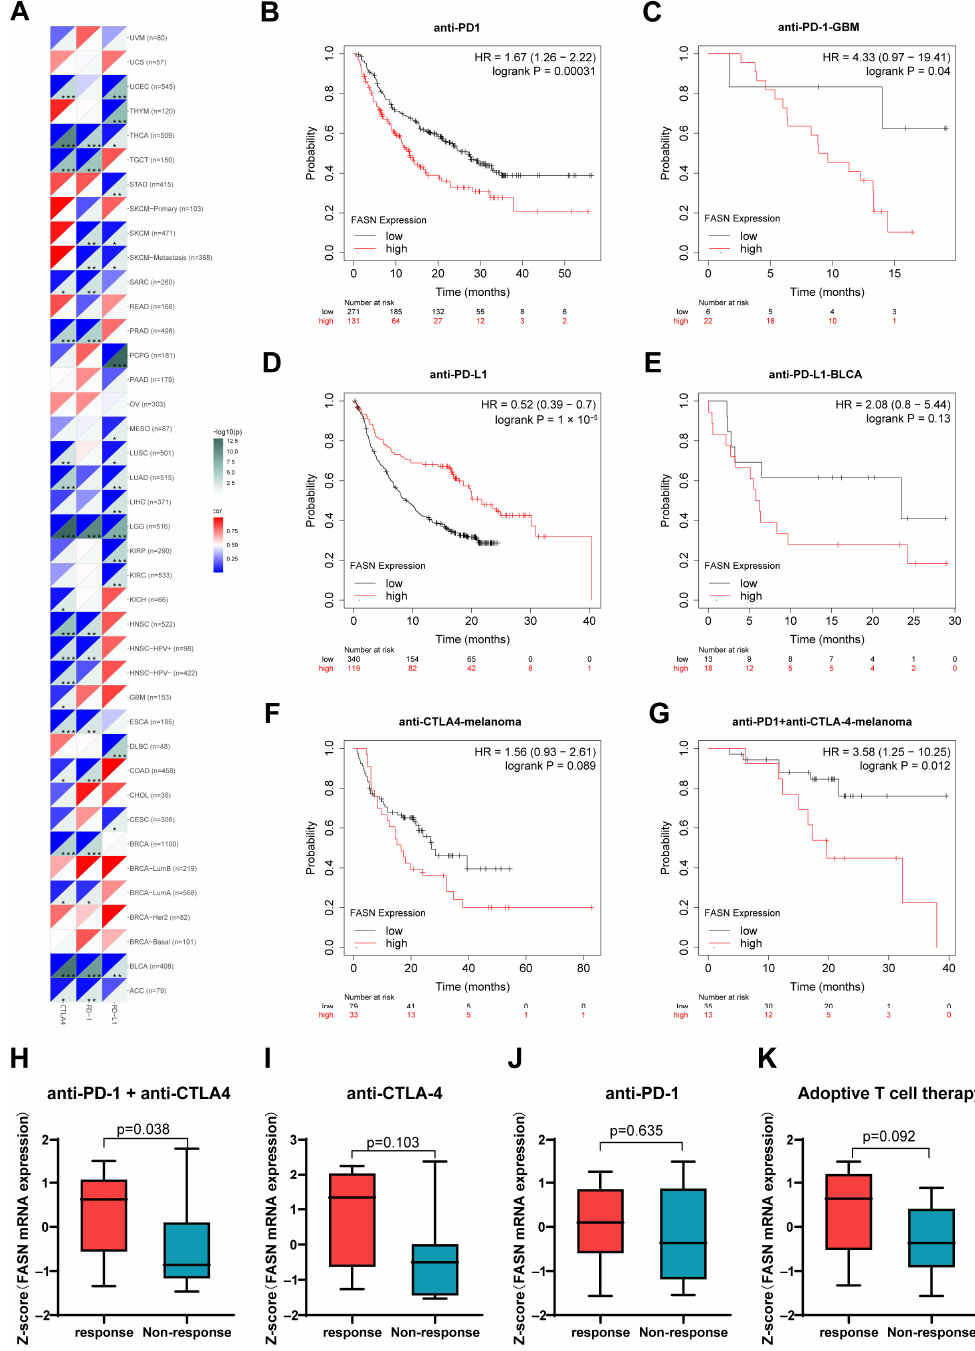
Figure 6. Correlation analysis of FASN expression with PD-1, PD-L1, and CTLA-4 and differential analysis of the two indicators to the responsiveness of immunotherapy. ( A ) Correlation of FASN expression with PD-1, PD-L1, CTLA-4 in pan-cancer. (* p < 0.05, ** p < 0.01, *** p < 0.001.). Prognostic value of FASN expression in patients with different cancers treated with anti-PD-1, ( B , C ) anti-PD- L1 ( D , E ), anti-CTLA-4 ( F ), anti-PD-1 combined with anti-CTLA-4 ( G ), respectively. Correlation of FASN expression with four immunotherapy responses of anti-PD-1 combined with anti-CTLA-4 ( H ), anti-CTLA-4 ( I ), anti-PD1 ( J ), and adoptive T cell therapy ( K